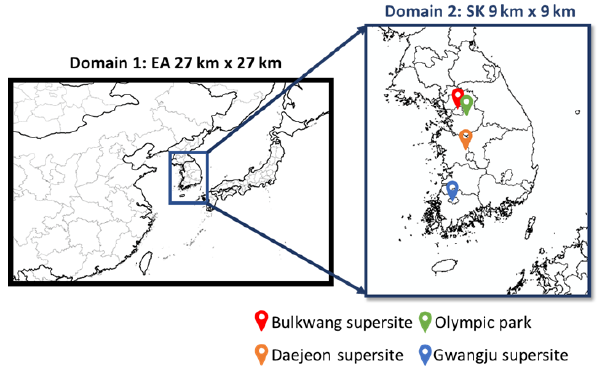
Figure 2. Simulated domain and observation sites during the KORUS-AQ campaign. “EA” and “SK” represent eastern Asia and South Korea,